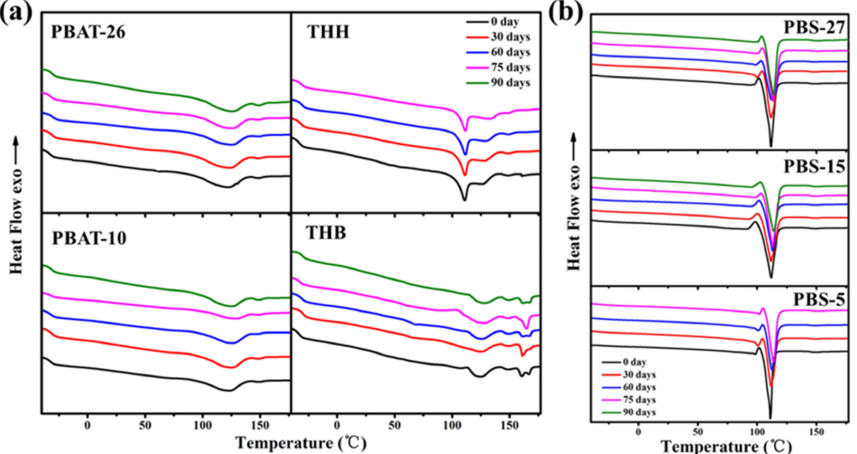
Figure 3. DSCmeltingtracesof( a )PBATand( b )PBSmulchingfilmsbeforeandaftera75-daydegradation.